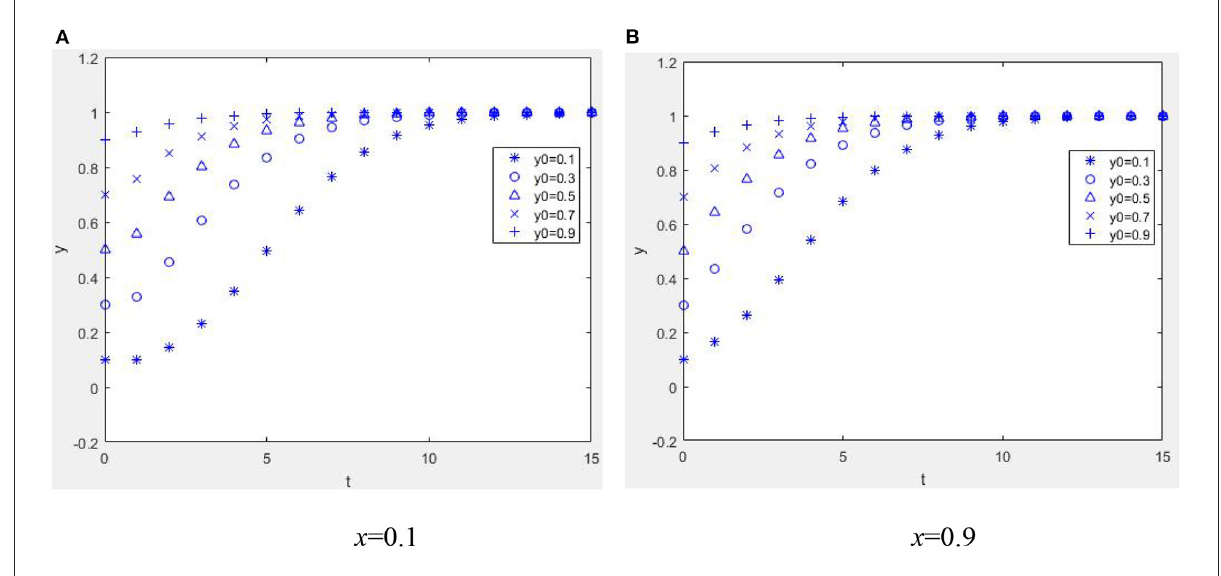
FIGURE8 Dynamic evolution diagram under Case 4. (A) x = 0.1 and (B) x =